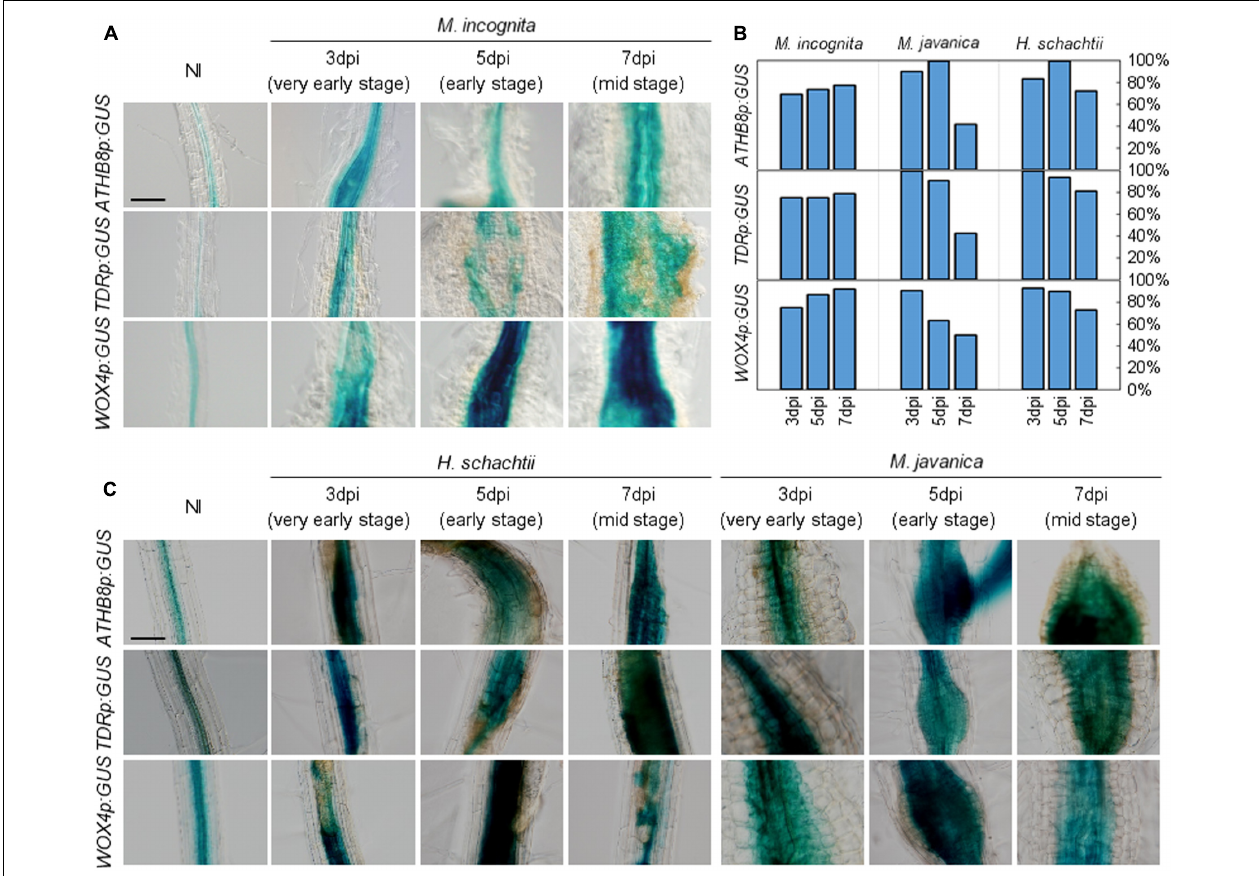
FIGURE 5 | Promoter activities of procambium-associated genes are induced in galls. Five-day-old Arabidopsis seedlings harboring the ATHB8p:GUS , TDRp:GUS, or WOX4p:GUS constructs were inoculated with M. incognita (A) , H. schachtii or M. javanica (C) . GUS activity was detected in the vascular bundles of non-infected roots, while GUS signals were expanded in 3, 5, and 7 dpi galls within the vascular cylinder. Scale bar = 100 µ m. (B) Penetrance of GUS staining in RKN-induced galls and H. schachtii -induced syncytia carrying the GUS reporter constructs, as some of the galls/syncytia did not show GUS staining. Bars denote the percentage of galls/syncytia that are GUS-positive (fully or partially stained with